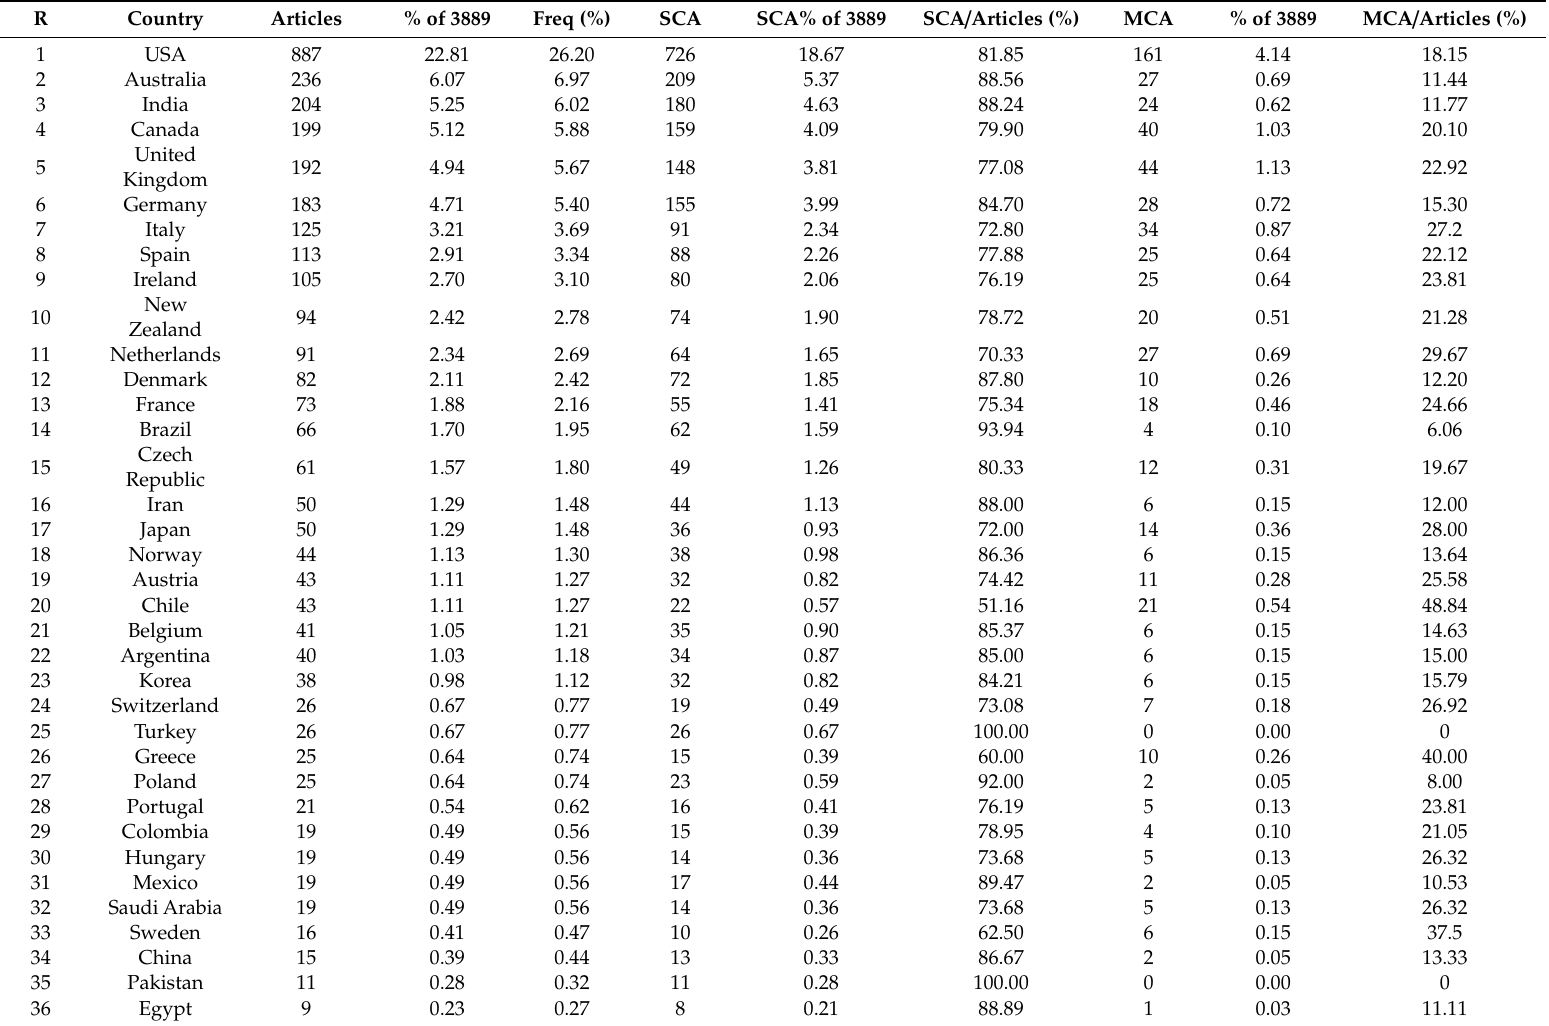
Table 4. Country participations in MAP research from